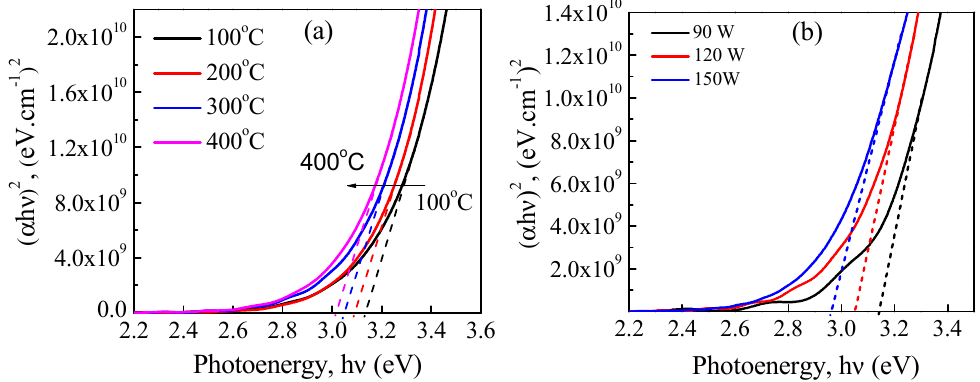
Figure 4. Plots of ( α h ν ) 2 vs. photon energy ( h ν ) for the optical band gap determination of the Ge 0.07 GaN films sputtered in a ( a ) deposition temperature (100–400 °C) range; ( b ) RF reactive sputtering range of 90–150 W.